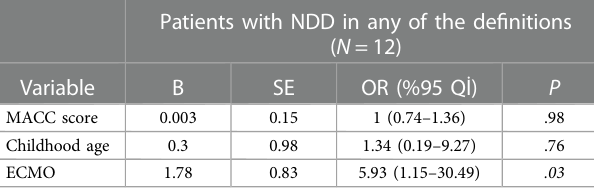
TABLE 5 Multivariate logistic regression analyses on neurodevelopmental delay. Patients with NDD in any of the de fi